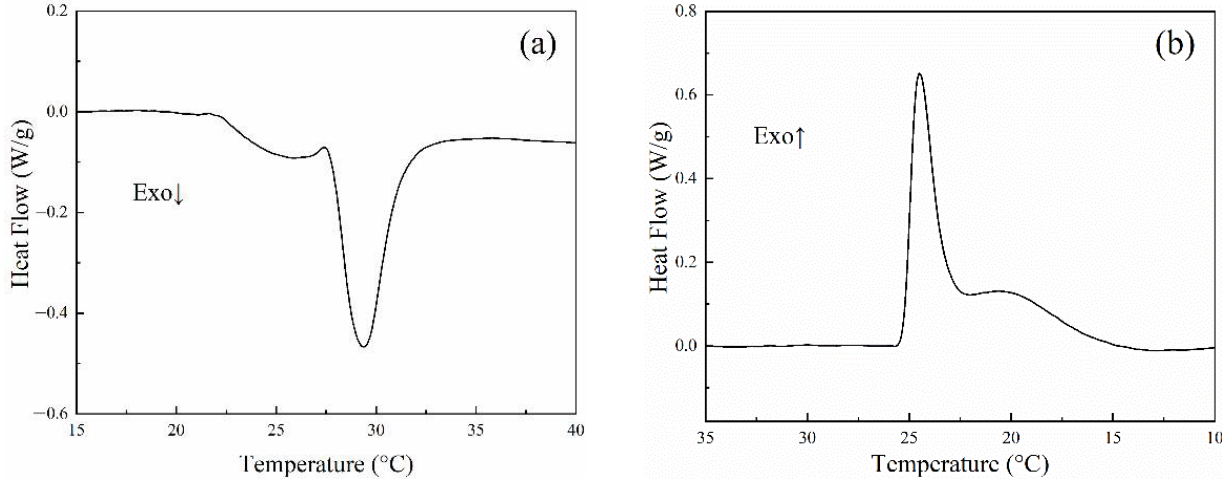
Figure 6. DSC curves for phase change thermoregulated fibers ( a ) heating curve ( b ) cooling curve.